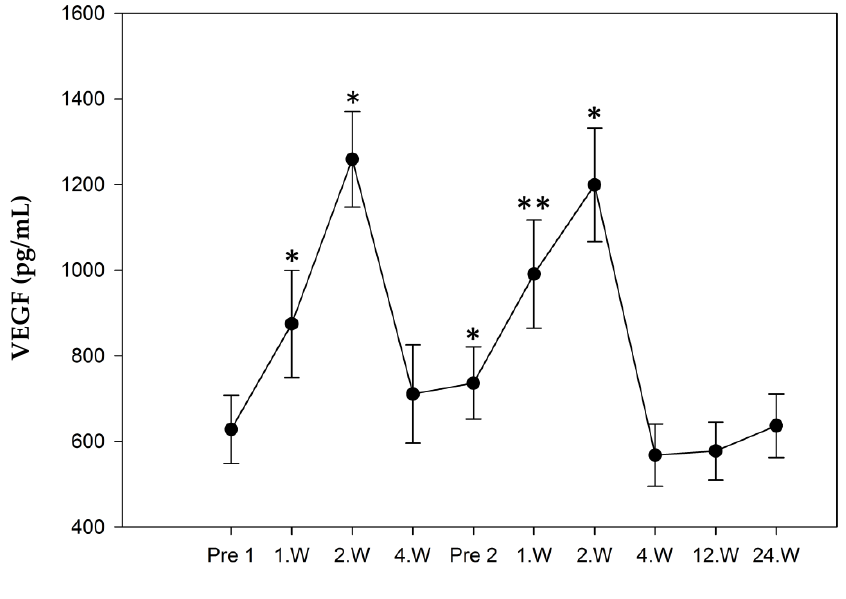
Figure 4. VEGF mean concentrations over time in responder group (error bars: standard error of the mean, * significant p < 0.05, ** very significant p < 0.01), all values compared to Pre 1 (preoperative value before Step 1). VEGF levels were significantly higher in week 1 and 2 after step 1 and 2 and preoperative before step 2. Maximum concentration of VEGF at second week after step 1.